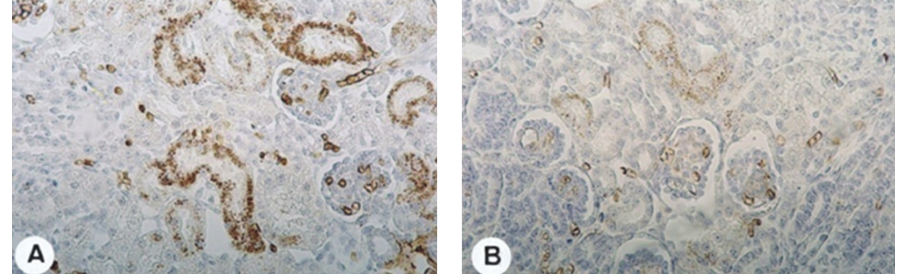
Figure 2: Immunolocalization of phospho-extracellular signal-regulated protein kinase (p-ERK) in renal cortex of o ff spring from dams submitted (B) or not (A) to high-sodium intake during pregnancy and lactation at 1 day of age (original magnification 280x). Note that the reactions are more intense in (A) than in (B).